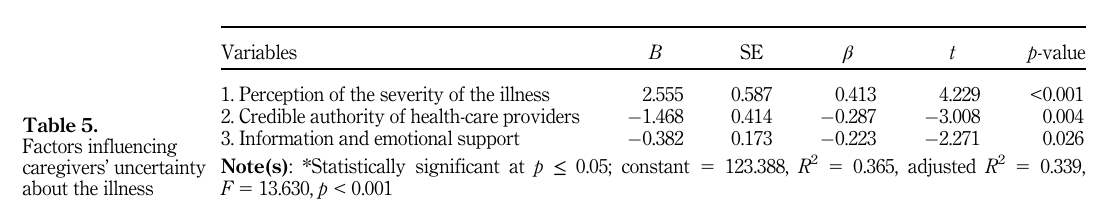
Table 4. Correlation of the variables